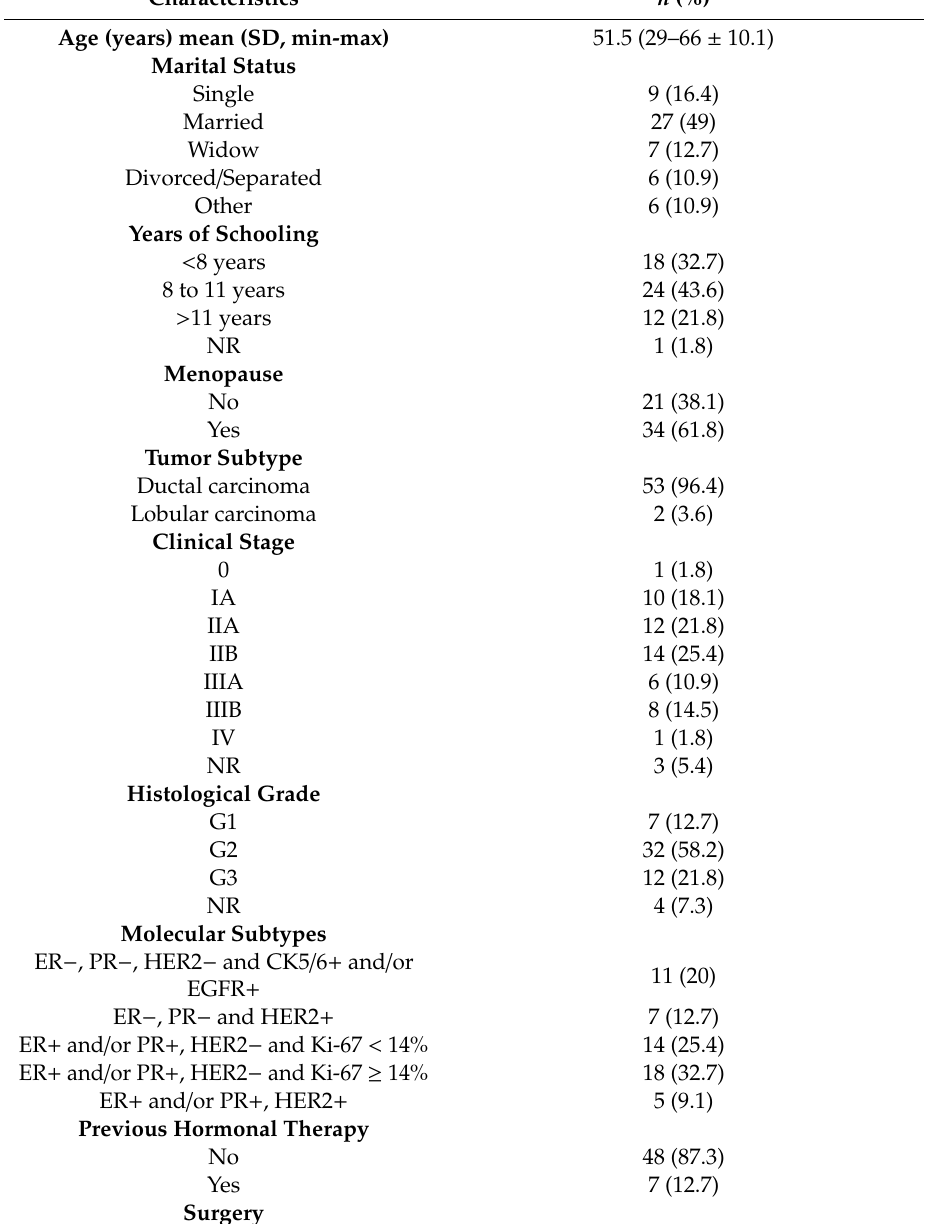
Table 1. Clinical, hormonal and therapeutic characteristics of women with breast cancer ( n =